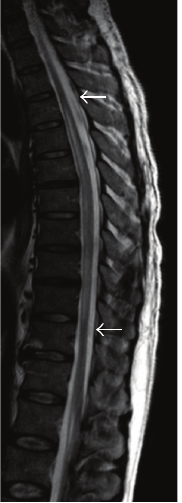
Figure 1: Sagittal T2-weighted spinal MRI shows an intramedullar hyperintense lesion extending from T4 to T10 (between the arrows).